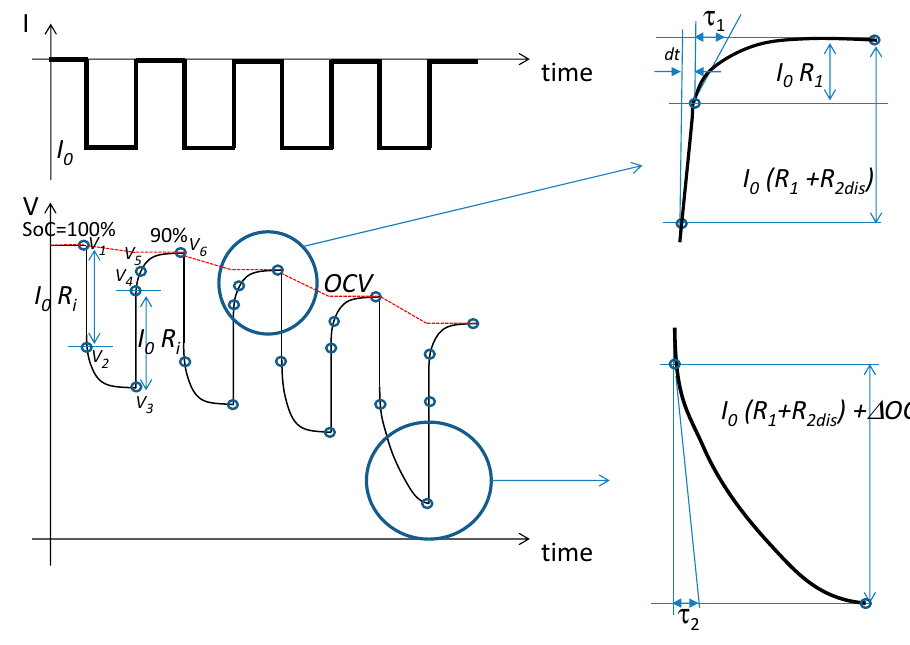
Figure 4. Extraction procedure. SoC: state of charge.